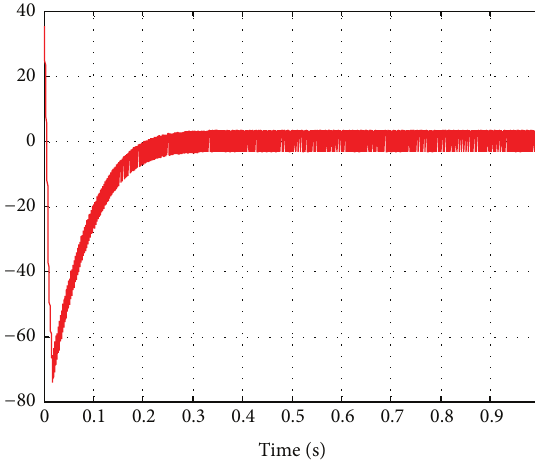
Figure 4: Output ( 𝑥 ).